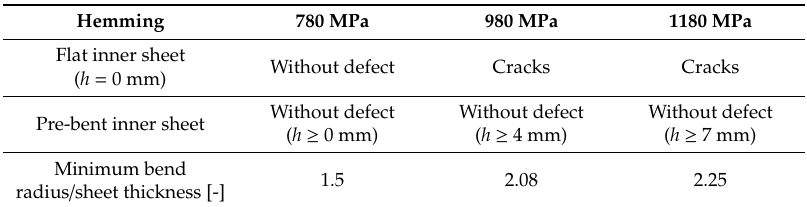
Table 2. Minimum bend radius ratio of steel sheets.